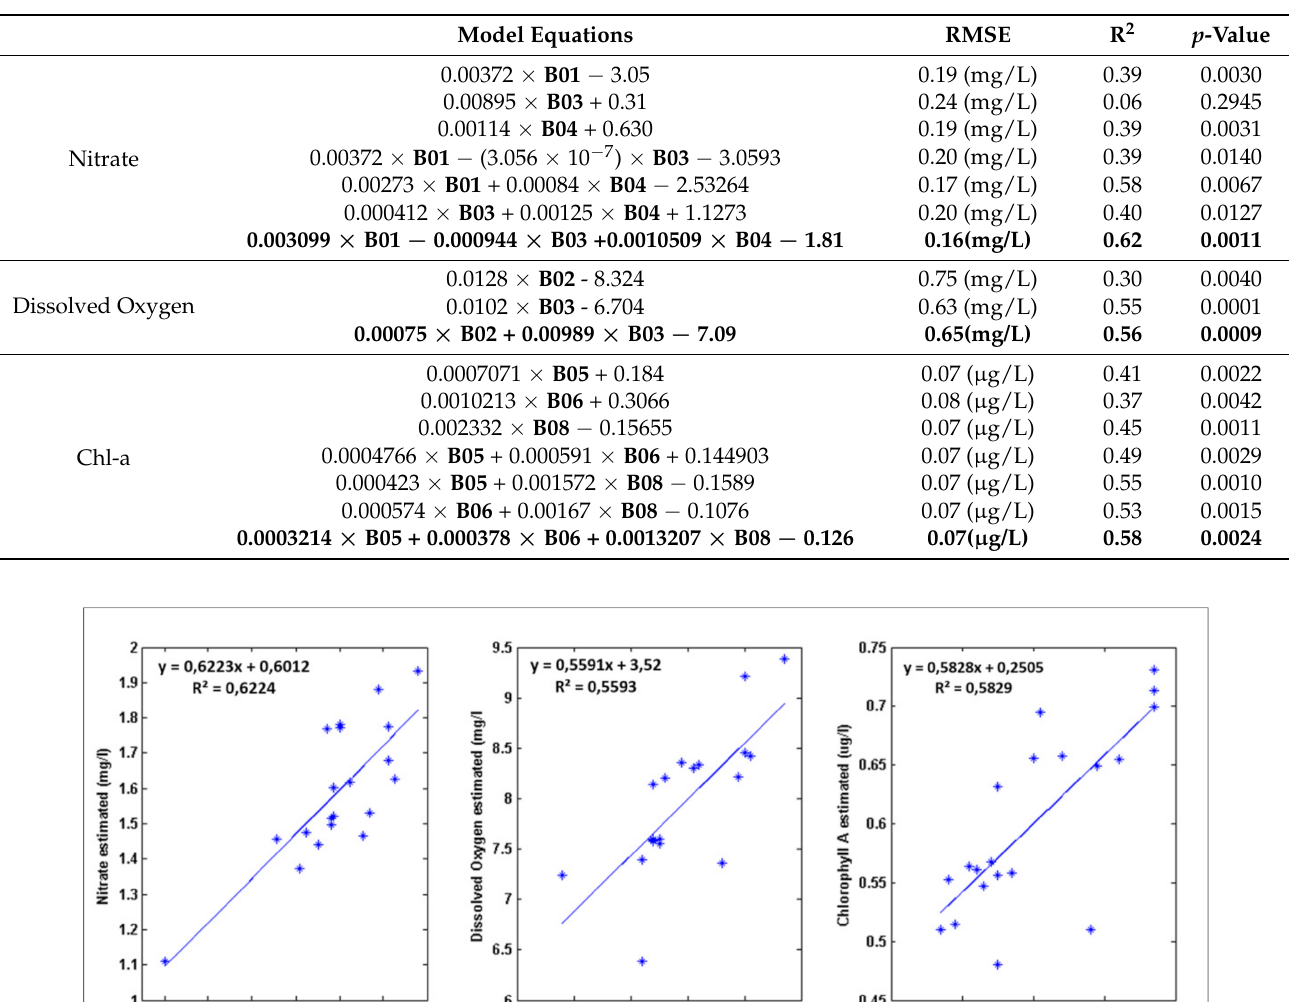
Table 5. Statistical parameters of the best performance models.